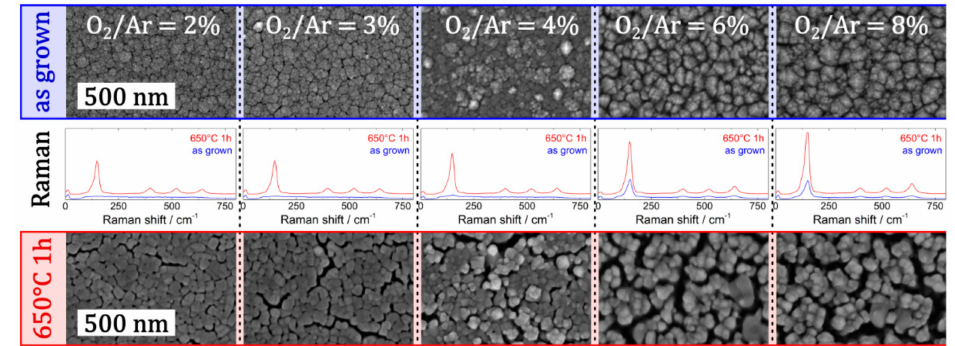
Figure 7. Impact of a variation of O 2 / Ar flow ratio on the morphology and crystallinity of a TiO 2 thin film deposited by sputter deposition: Top view SEM micrographs (having same scale bar of 500 nm) of the as-grown thin film (upper row) and the thin film with nanocrack networks after heat treatment at 650 ◦ C for 1 h (bottom row). The corresponding Raman spectra are depicted in the middle row. Adapted with permission from [24]. Copyright (2019)